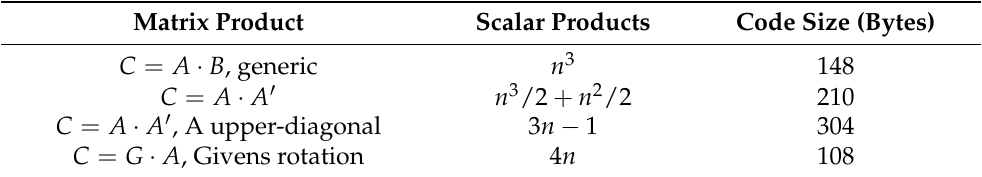
Table 3. Number of scalar multiplications in matrix products for different types of n × n input